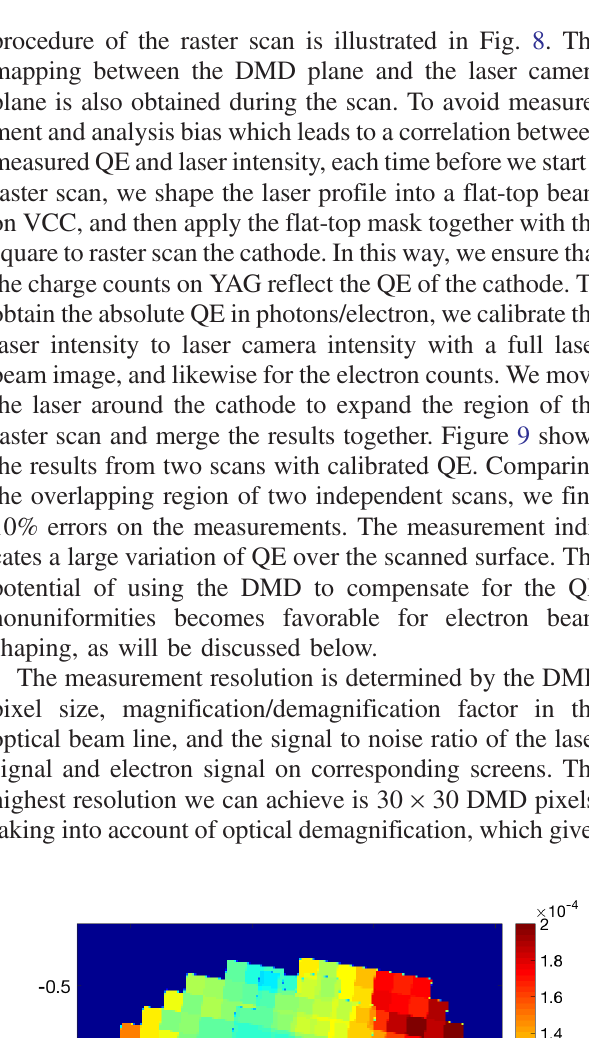
FIG. 8. Illustration of raster scan to obtain a QE map across the laser illumination area on cathode.